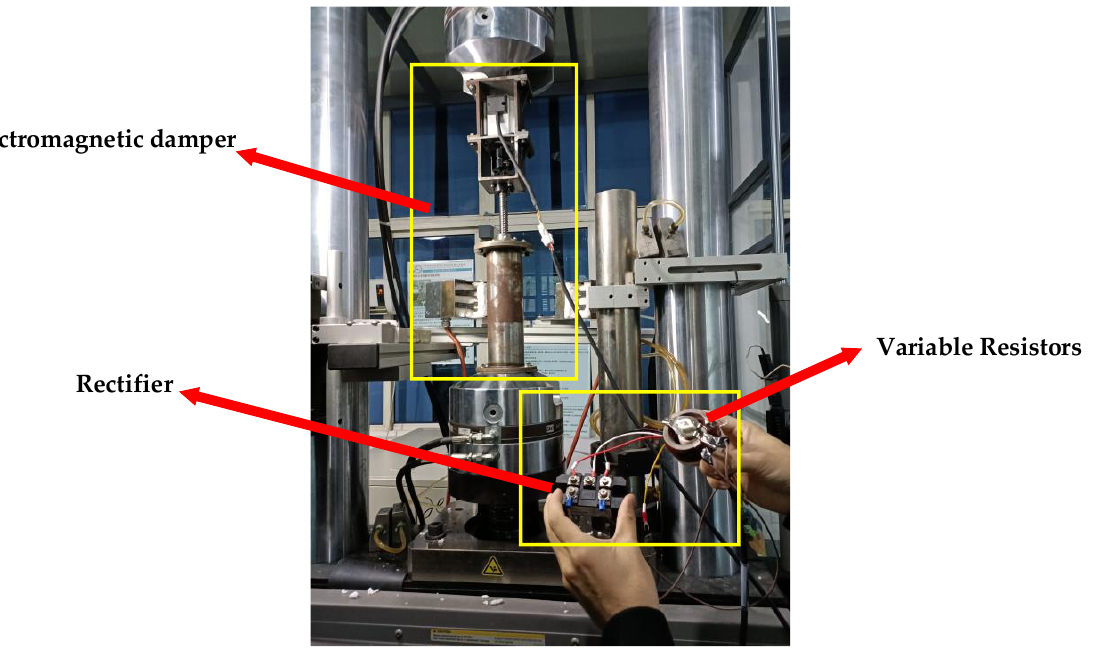
Figure 7. Experimental system with MTS.